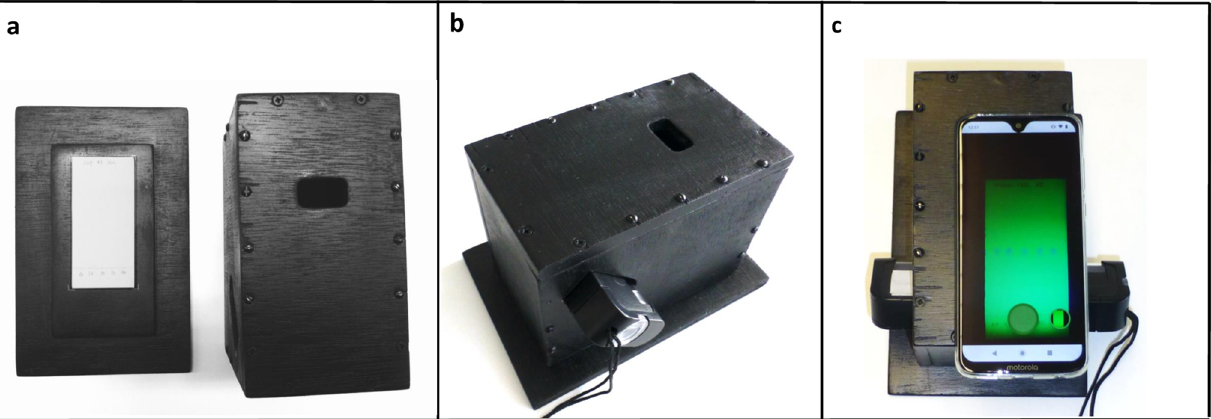
Figure 1. Box for photography of TLC plates under UV illumination. ( a ) Left: Bottom plate with TLC plate. Right: box-shaped lid with openings for the UV lamp and for photography. ( b ) Assembled box with the UV lamp inserted. ( c ) Assembled box with TLC plate, UV lamp, and